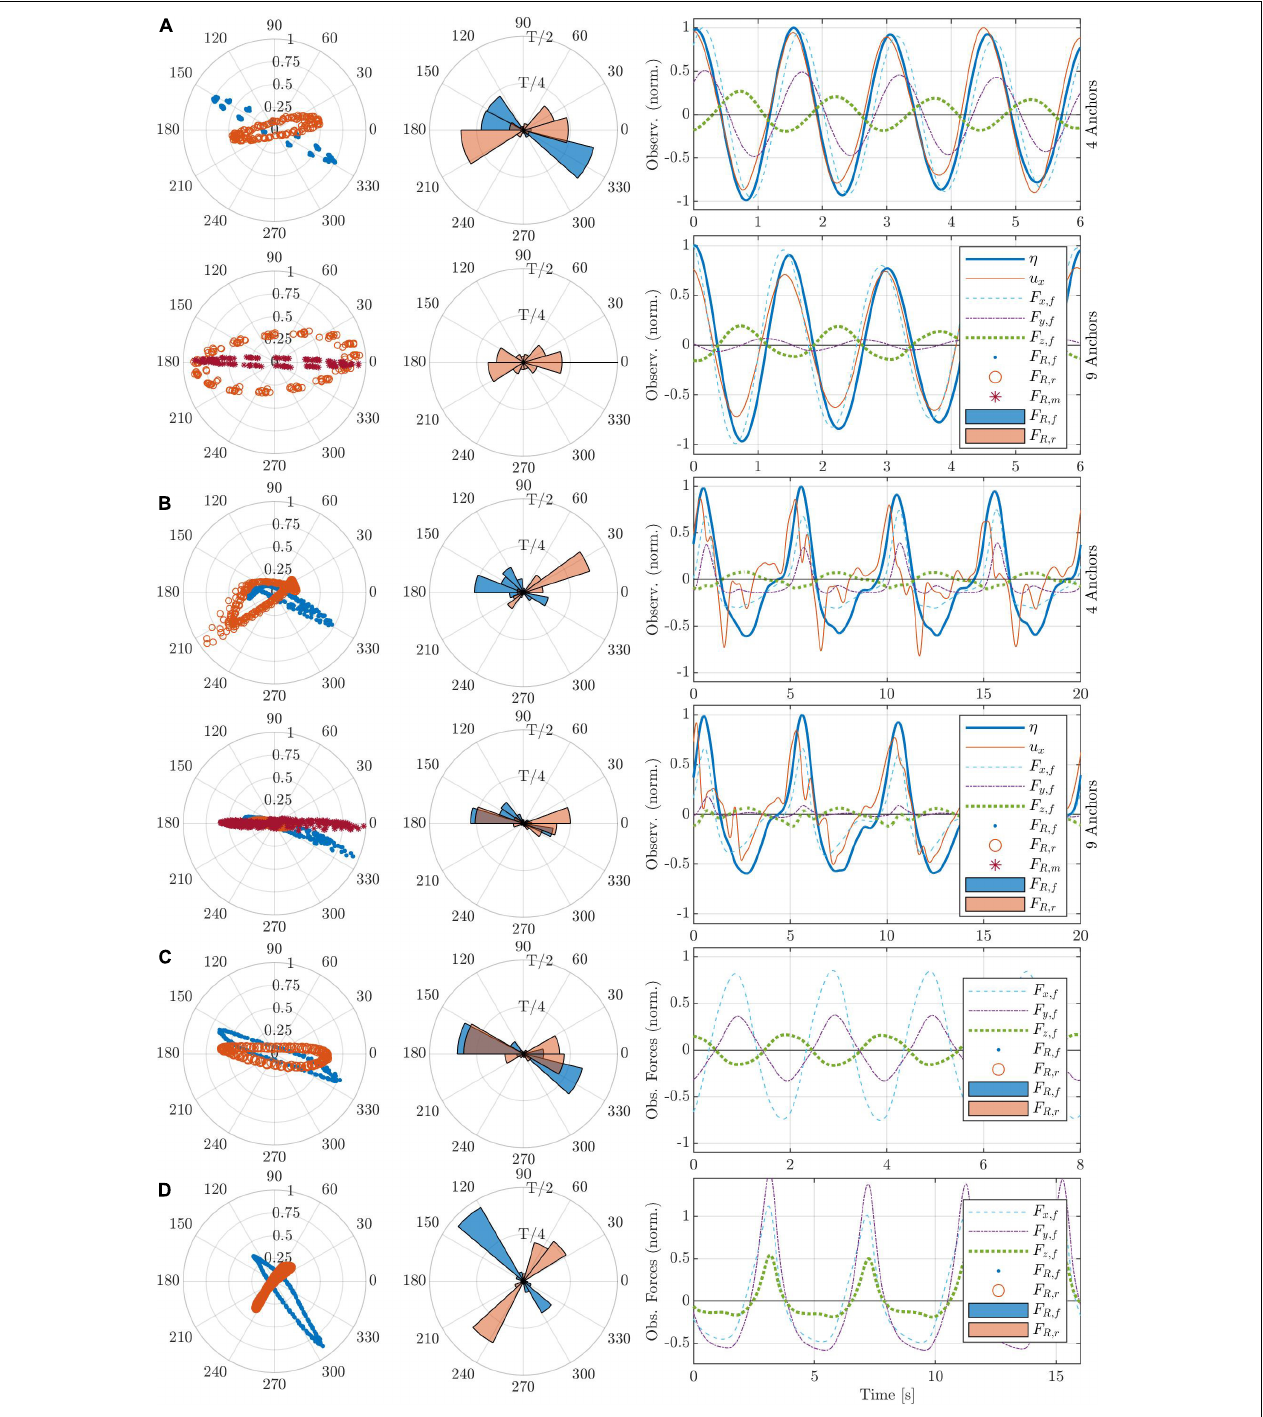
FIGURE 6 | Observations and calculated resultant force magnitude and direction for panels (A) CM2, T = 1.5 s and H = 0.02 m; (B) CM2, T = 5 s and H = 0.08 m; (C) 1 ASG Mat, T = 2 s and H = 0.11 m; and (D) 2 ASG Mats, T = 4 s and H = 0.06 m. Plots in panels (A,B) show the CM configurations for 4 (top) and 9 (bottom) anchors. In panels (C,D) the vegetated runs (AV) are shown; note that in AV, the water level and particle velocity were not measured aligned with the anchors and are thus not shown together here. Within each panel: (left) polar graph showing the resultant force magnitude (Equation 10 normalized by the maximum measured resultant force of the respective run) and direction (inverse tangent), with the direction of rear anchors (FT rc 4 and FT rc 9 ) inverted to be aligned with the front; (center) polar histogram showing the average spatial distribution of the forces at one anchor and the corresponding duration over one period T . (right) time series of 4 waves with observed post-processed data, with η the water level fluctuation. The legend within the time series refers to all subfigures within the respective panel, with subscripts f , r and m corresponding to front, rear and middle front anchors, respectively.